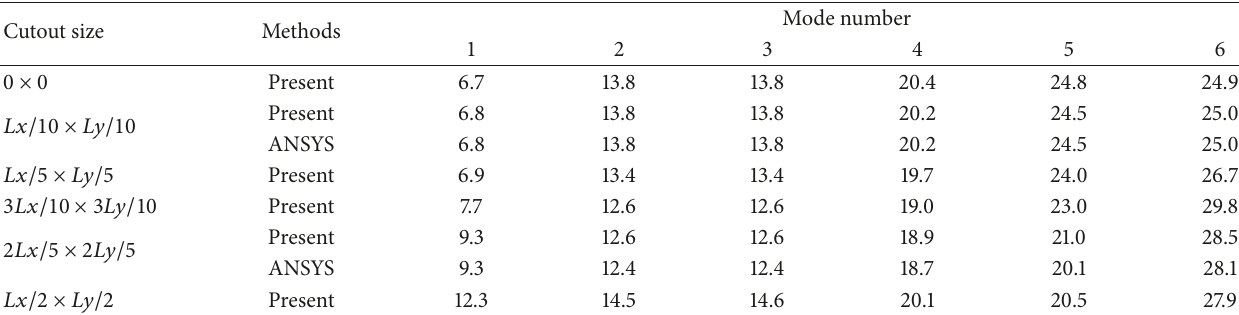
Figure 3: The first six natural frequencies of flexible plate with one cutout for different boundary restrained stiffness: (a) variation of the translational restraining stiffness; (b) variation of the rotational restraining stiffness. Table 3: The first six natural frequencies (Hz) for different square opening